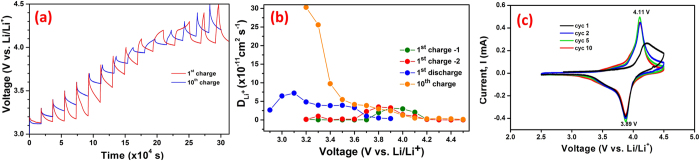
Li-diffusion and CV studies.(a) GITT studies of rGO/K2[(VO)2(HPO4)2(C2O4)] cathode; (b) Li diffusion coefficient versus cell voltage for the 1st charge and 10th charge cycles and (c) CVs of rGO/K2[(VO)2(HPO4)2(C2O4)].